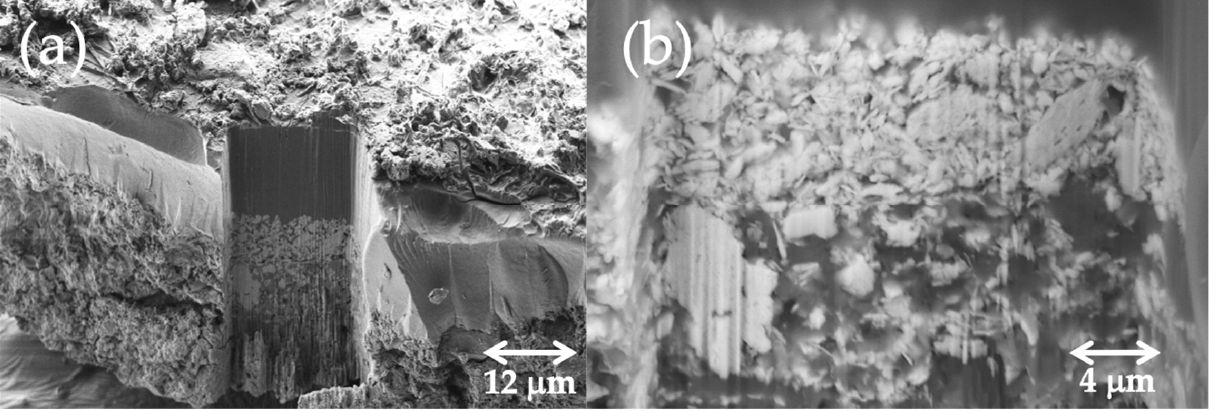
Figure 9. Secondary electron image of ( a ) the trench performed in sample F-1. ( b ) Detail of the morphology of lead white in layer two.